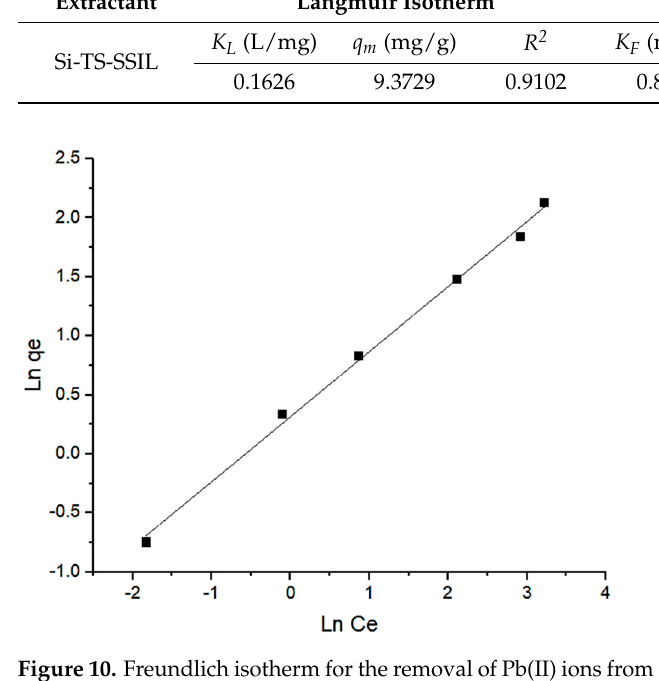
Figure 10. Freundlich isotherm for the removal of Pb(II) ions from aqueous solution by the Si-TS-SSIL.